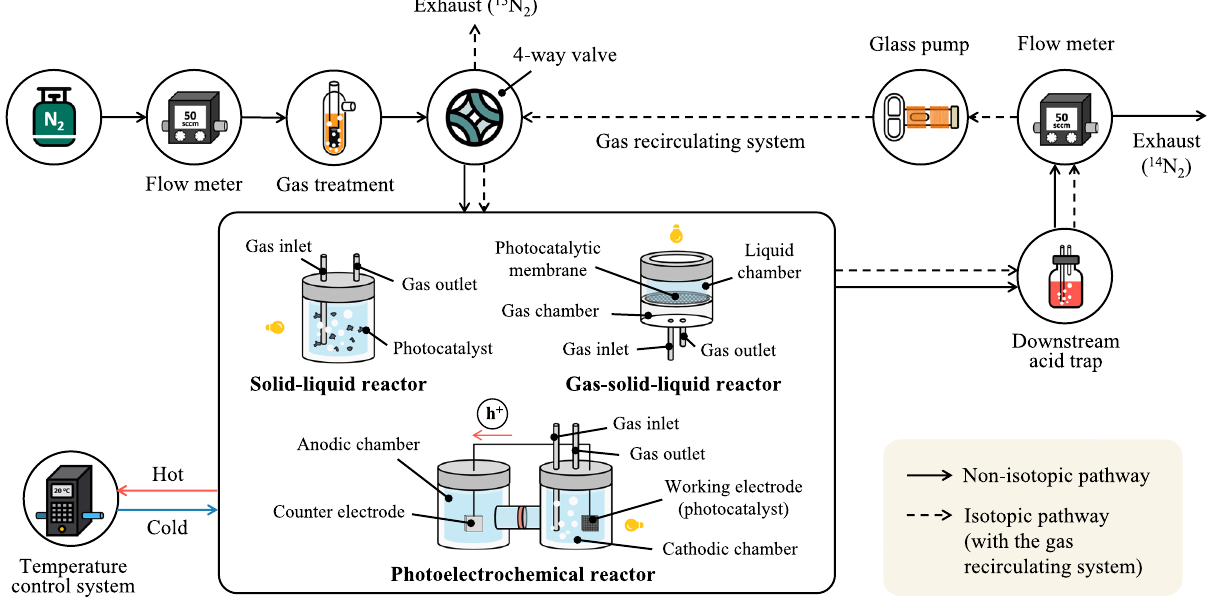
Fig. 1 | Schematic of the photocatalytic NRR system and different types of photocatalytic reactors. The solid line represents the non-isotopic pathway, and the dashed line represents the isotopic pathway. The fi rst fl ow meter is to control